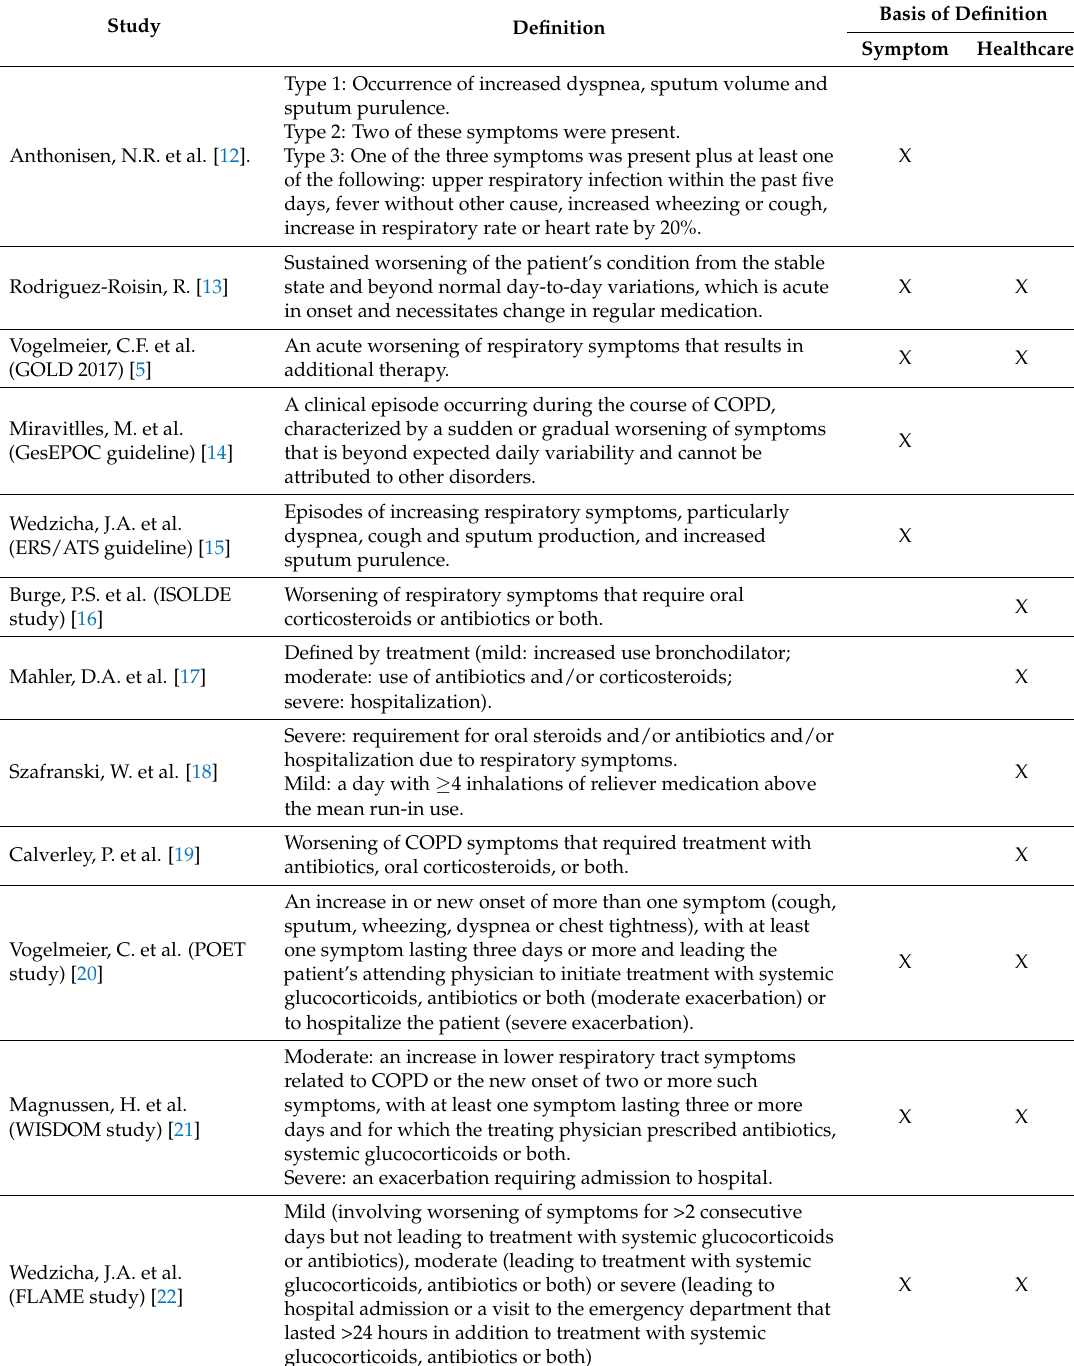
Table 1. Examples of chronic obstructive pulmonary disease (COPD) exacerbation definitions based on the presence of symptoms (symptom-based definition), the types of healthcare resources used (healthcare-based definition), or the combinations of